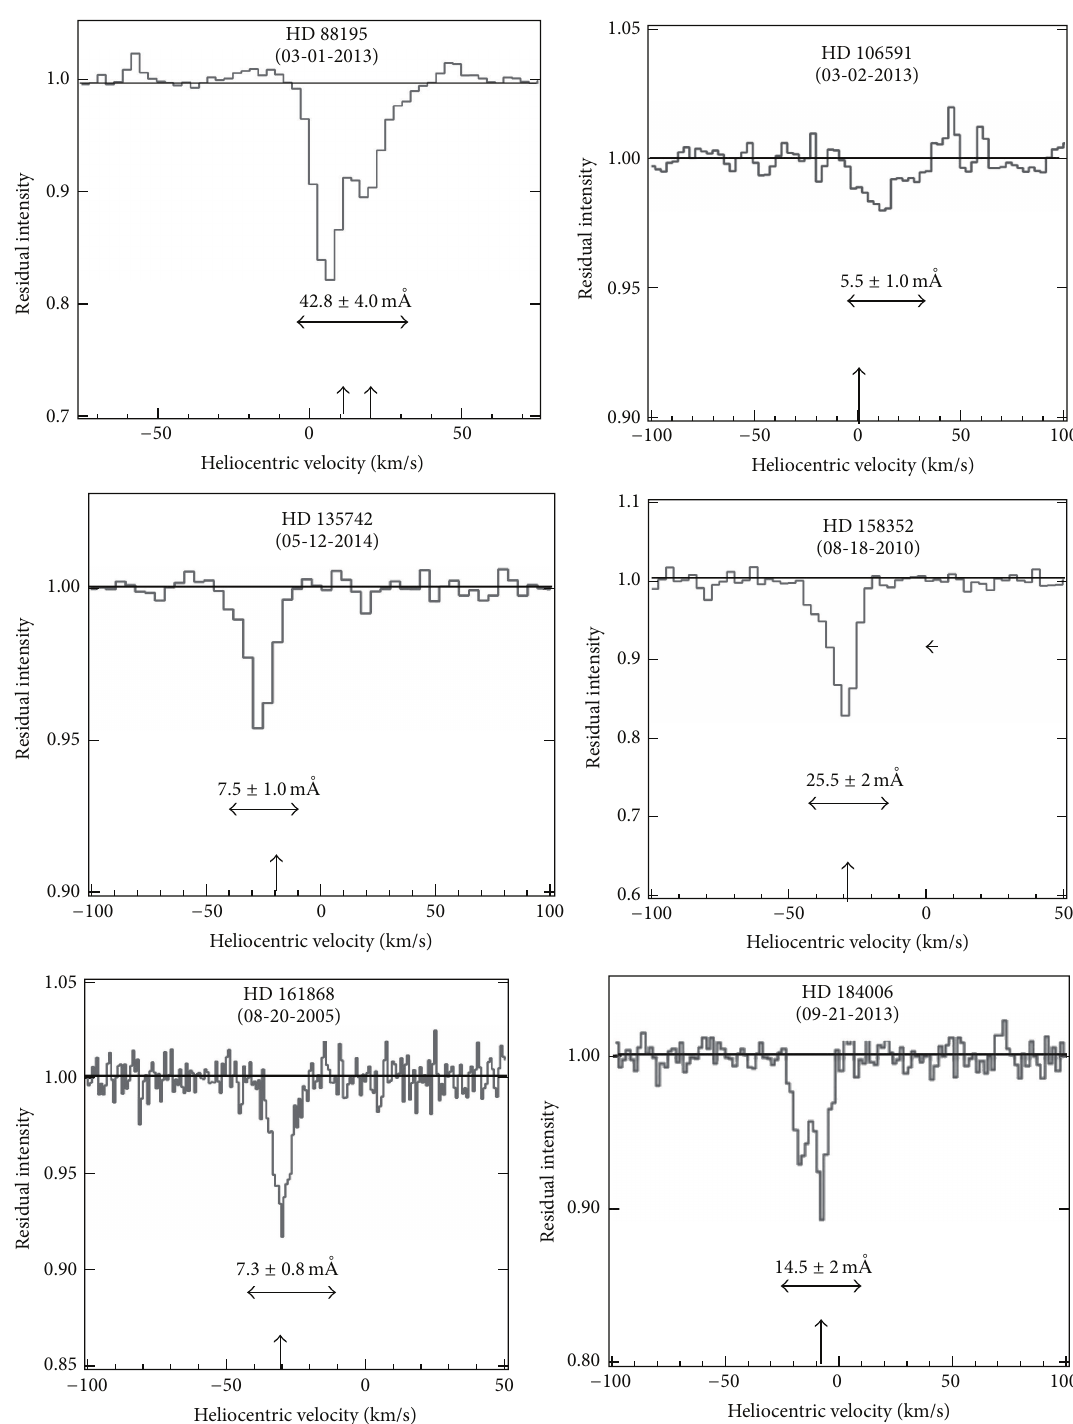
Figure 9: Stars showing no measurable change in their CaII K-line absorption between several nights’ observations. A typical spectrum from one night is shown for each of the 6 stars, together with their absorption EW value. The vertical arrow(s) shows the position of the projected velocity of the local interstellar cloud complex derived by Redfield and Linsky